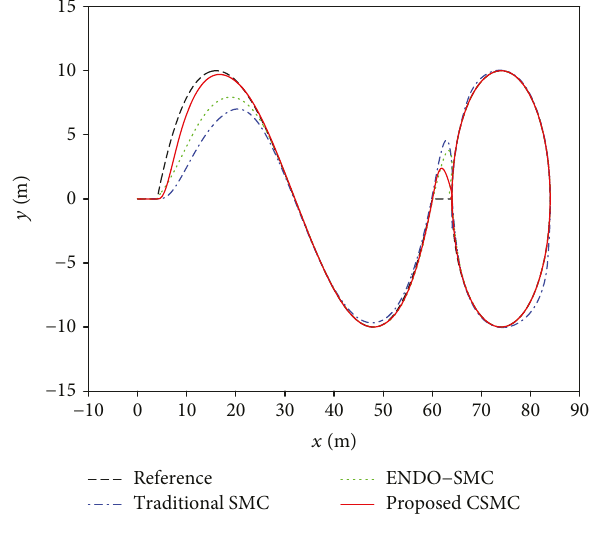
Figure 10: x - y plane of